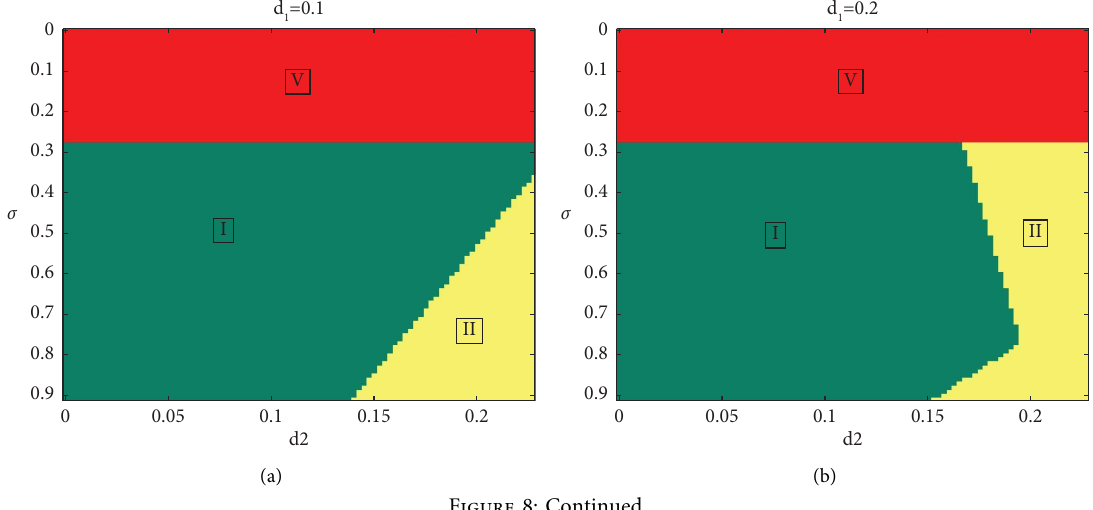
and σ , we choose R � 2 ,k � 1 , c � 0 . 8 , σ ∗ � 0 . 278655, and d 1